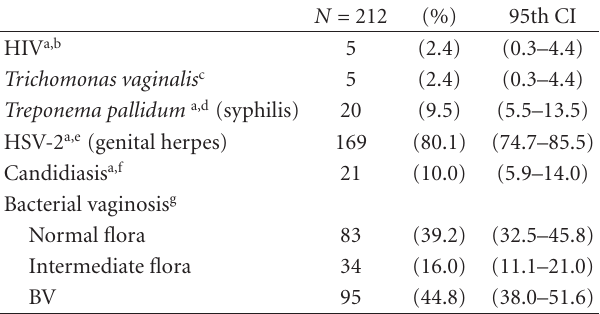
Table 2: STI/HIV and bacterial vaginosis prevalence among 212 clandestine female sex workers: Lima, Peru, 2003.